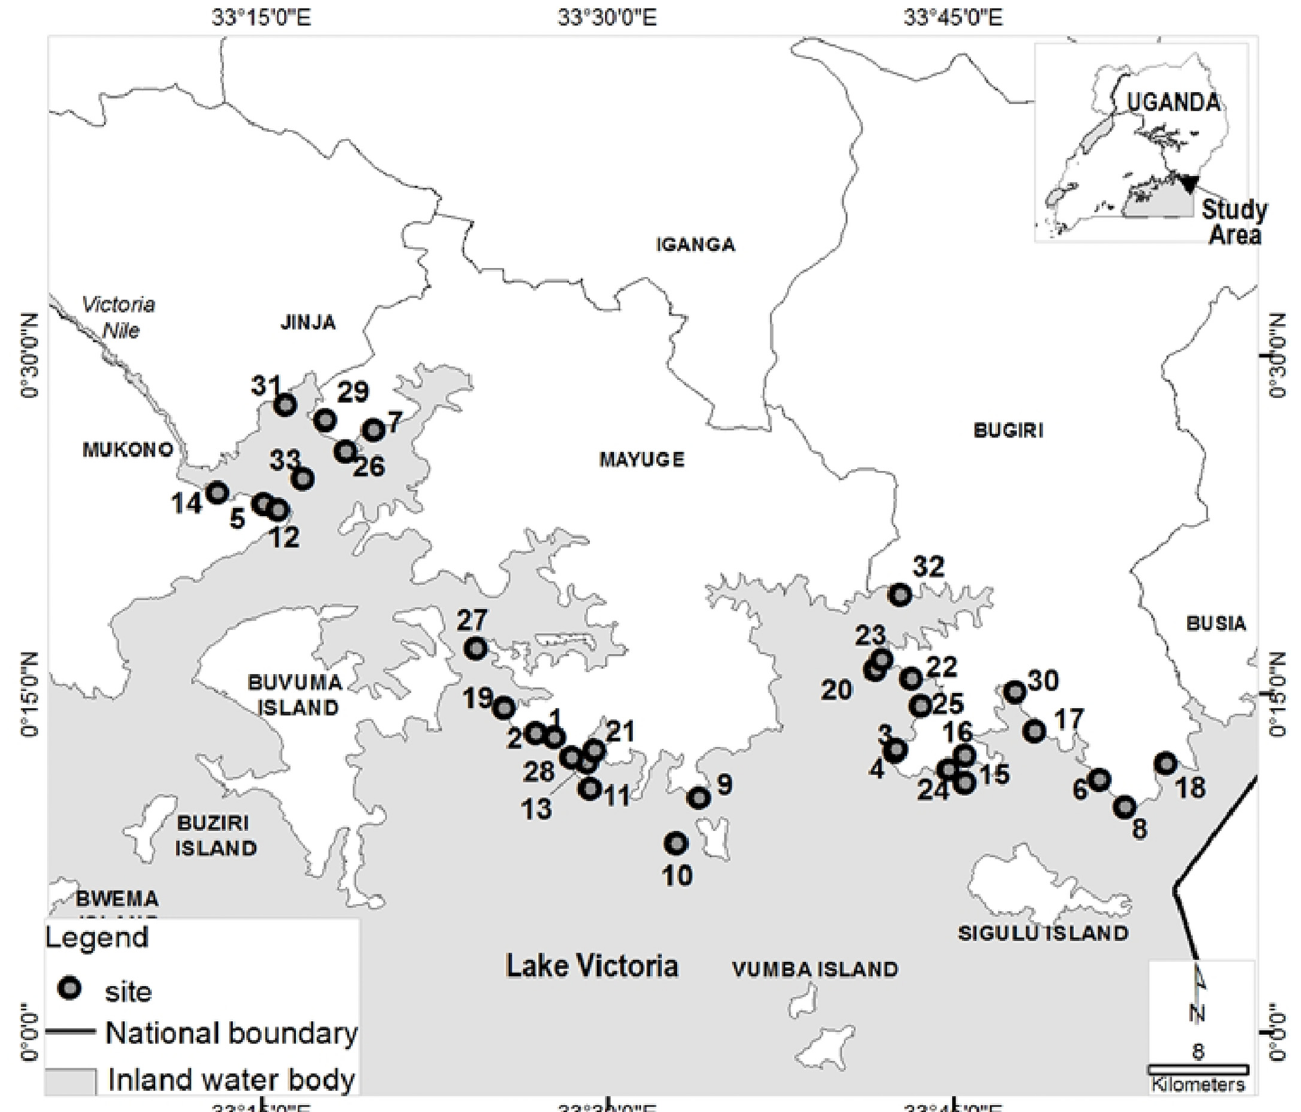
Fig 1. Map showing study sites along Lake Victoria, eastern Uganda. Study Sites1-Bukagabo A; 2-Bukagabo B; 3-Bumeru A; 4-Bumeru B; 5-Busana; 6-Busiro; 7-Busuyi; 8-Buyondo; 9-Bwondha; 10-Gori Island; 11-Kabuka; 12-Kalindi; 13-Kayanja; 14-Kikondo; 15-Lubango A; 16-Lubango B; 17-Lufudo; 18-Lugala; 19-Malindi; 20-Maruba; 21-Masaka; 22-Matiko; 23-Mpanga; 24-Mulwanda; 25-Musoli; 26-Musoli A; 27-Namoni; 28-Nango; 29-Ntinkalu; 30-Sidome; 31-Wairaka; 32-Wakawaka; 33-Kisiima